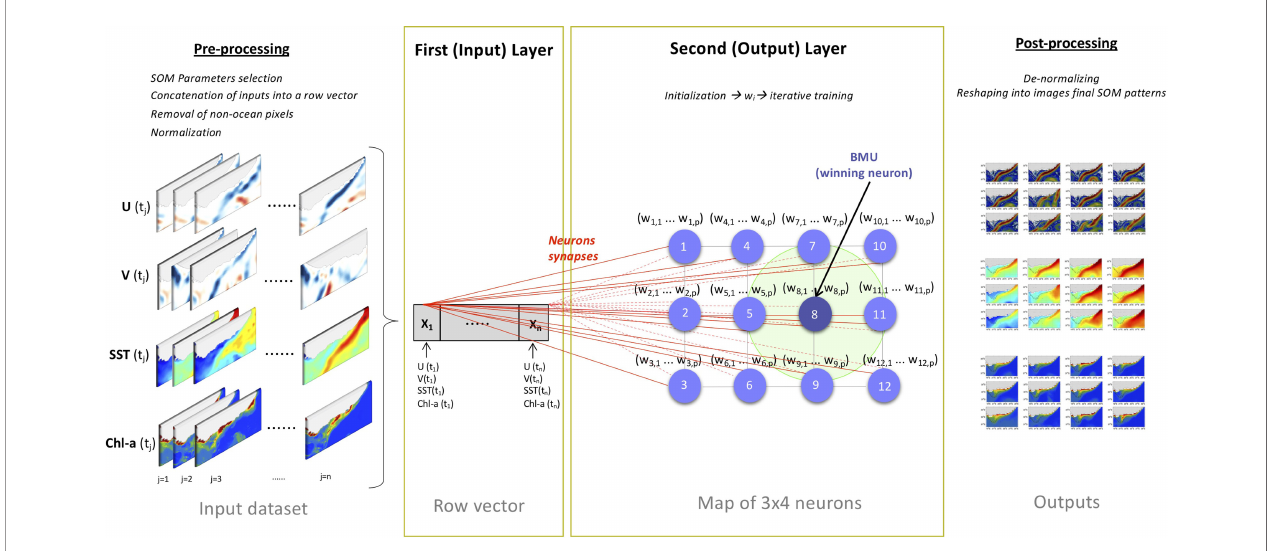
FIGURE 2 | Summary diagram of the 3x4 SOM architecture and functioning described in section 2.2. During the pre-processing, the input dataset which consist of 2-D daily satellite data (U(tj), V(t j ), SST (t j ), Chl-a(t j ) with j=1: n days) is concatenated into a row vector X (which makes up the input layer). X is composed of n=3479 arrays (one for each day of the observational record) each of p=4416 elements (1104 pixels *4 variables). Each SOM neuron (or pattern) gets assigned a weight vector ((w 1,1 … w 1,p) … (w 12,1 … w 12,p) ) that changes with the iterative training (second layer). When a BMU (wining neuron, dark blue circle) is found its weight vector and neighbouring neurons (light green shaded area) are updated. During the post-processing, the SOM outputs are reshaped into 2-D